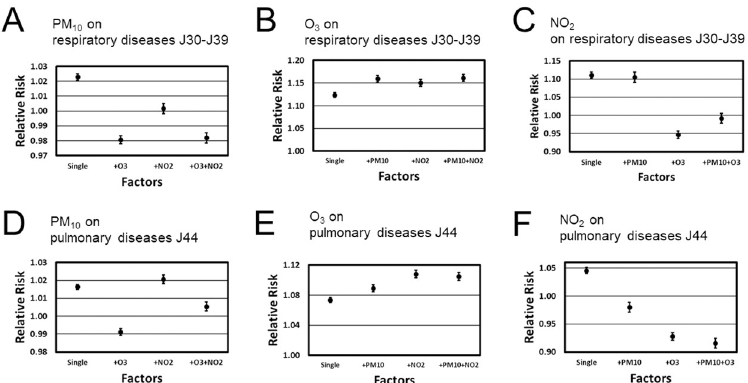
Fig 2. Associations between 10 unit increases in PM 10 , O 3 , NO 2 concentrations and upper (panels A, B, C) and lower (panels D, E, F) respiratory tract disease cases in the Chiang Mai area as determined by single- and multi- pollutants models as captured in terms of estimated RR